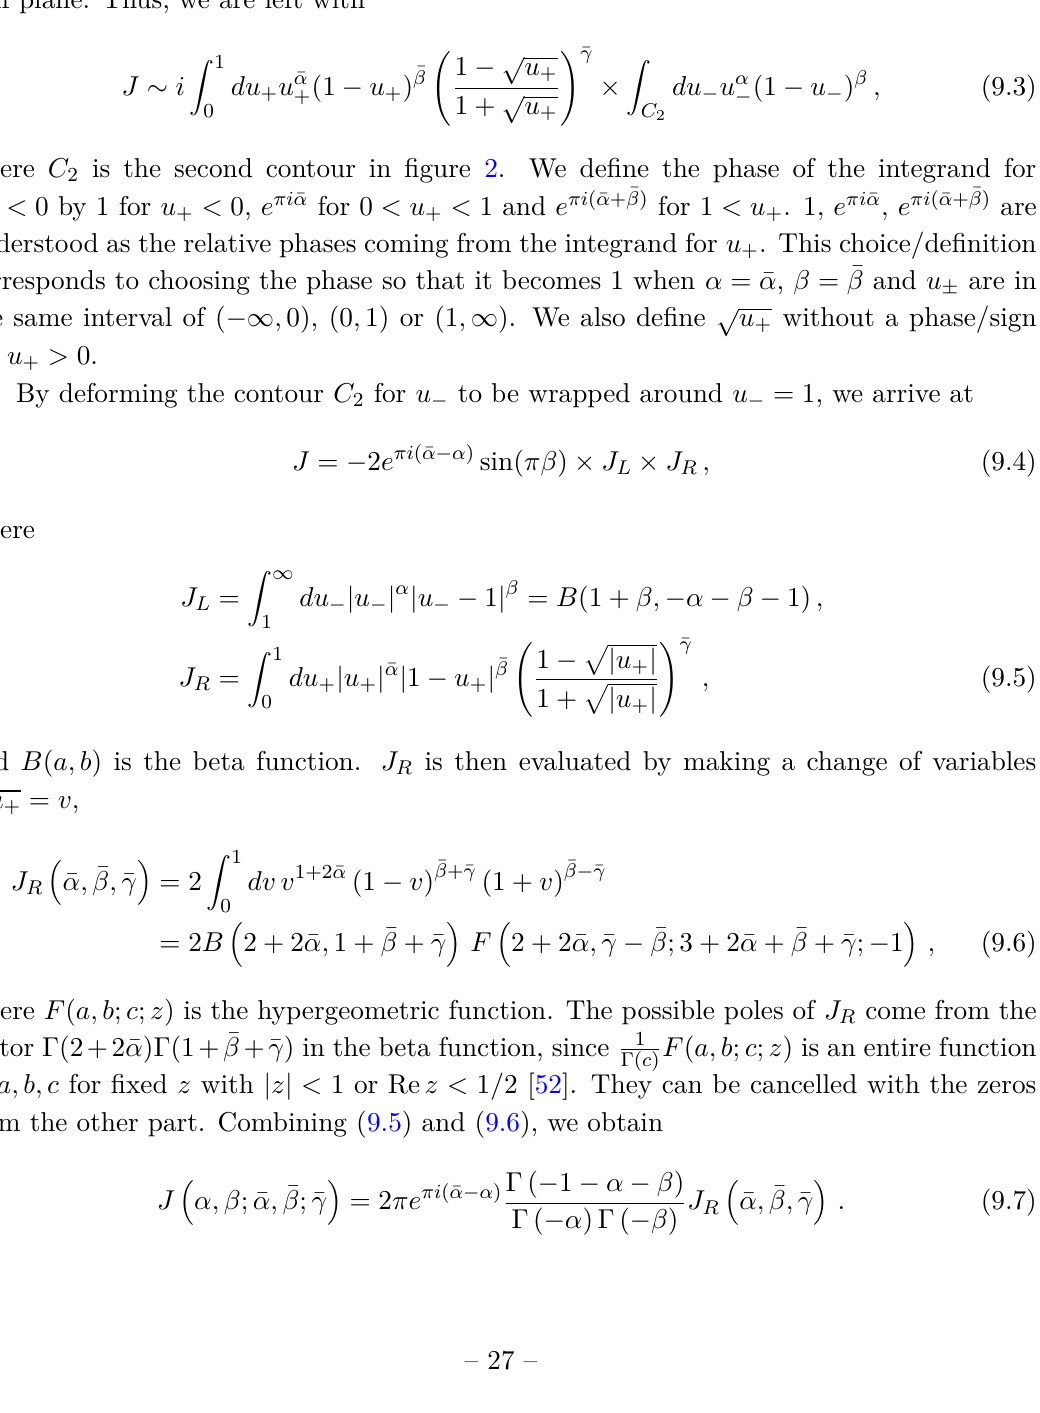
Figure 2 . Contours of u − -integral. C 1 , C 2 , C 3 are for u + < 0 , 0 < u + < 1 and 1 < u + , respectively. u < 0 and 1 < u vanish, which is confirmed by closing the contour in the lower/upper + + half plane. Thus, we are left